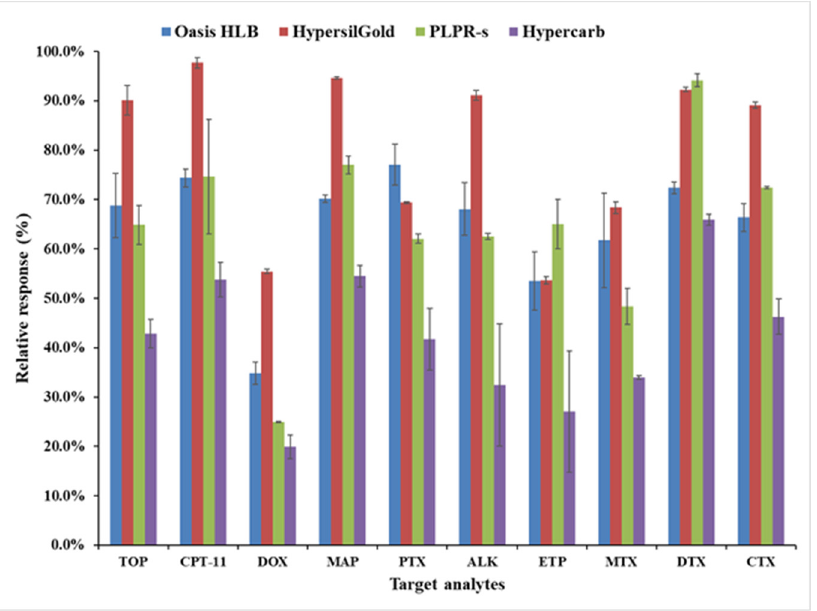
Figure 3. Comparison of the recoveries (relative peak area responses) obtained with four online SPE cartridges (analyte concentration 1.0 µg L − 1 , sample volume 500 µL, n = 3